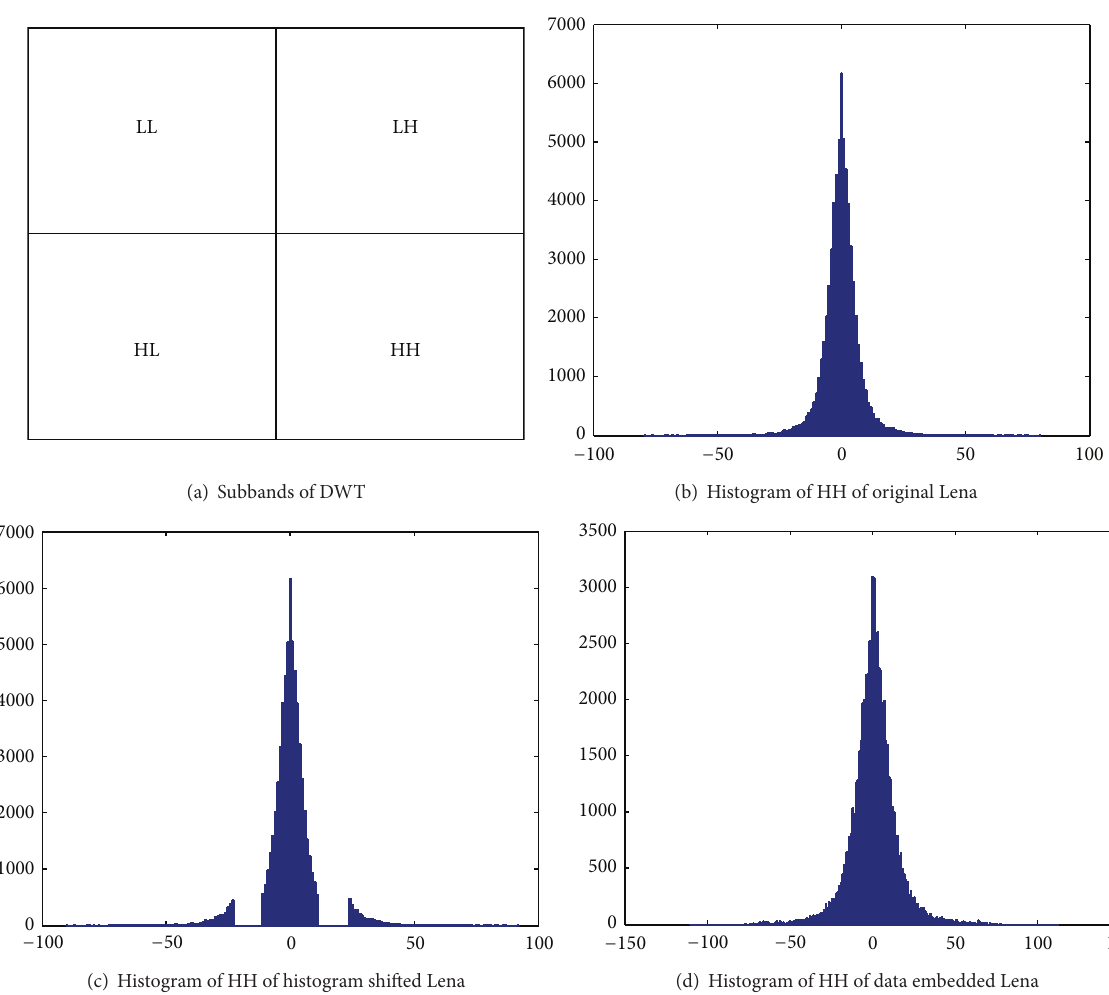
Figure 1: An example of histogram modification (HH subband of integer DWT of